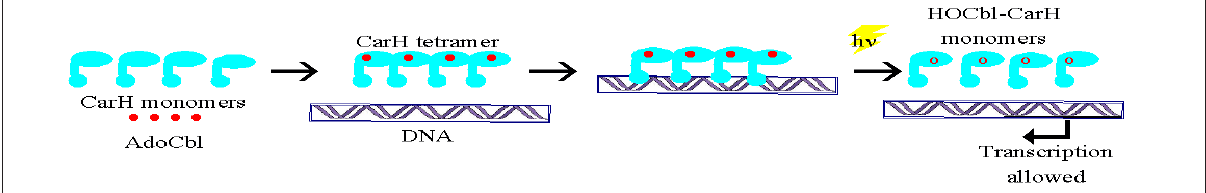
Figure 2: Model for the response to light of the AdoCbl regulatory switch in Myxococcus xanthus . 6 In the dark, AdoCbl binds to CarH monomers to give the CarH tetramer and the CarH tetramer binds to DNA, preventing transcription. In the presence of light, AdoCbl is photolysed and CarH dissociates, allowing